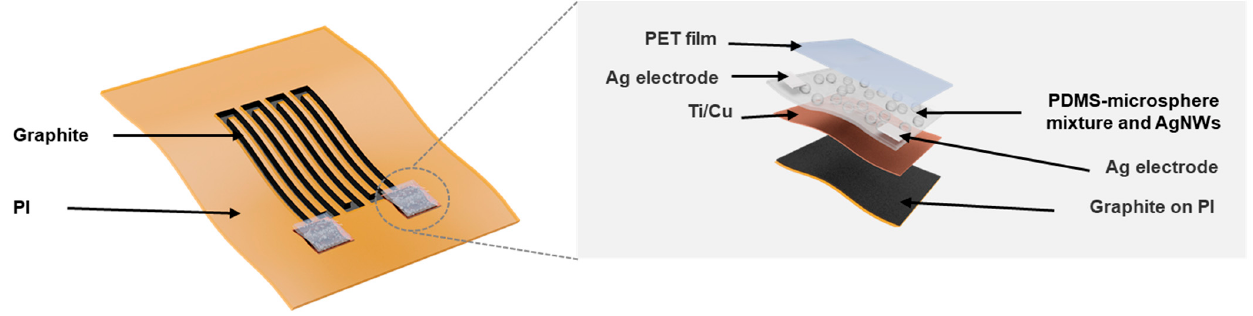
Figure 1. Structure diagram of a flexible integrated bending strain and pressure sensor system.